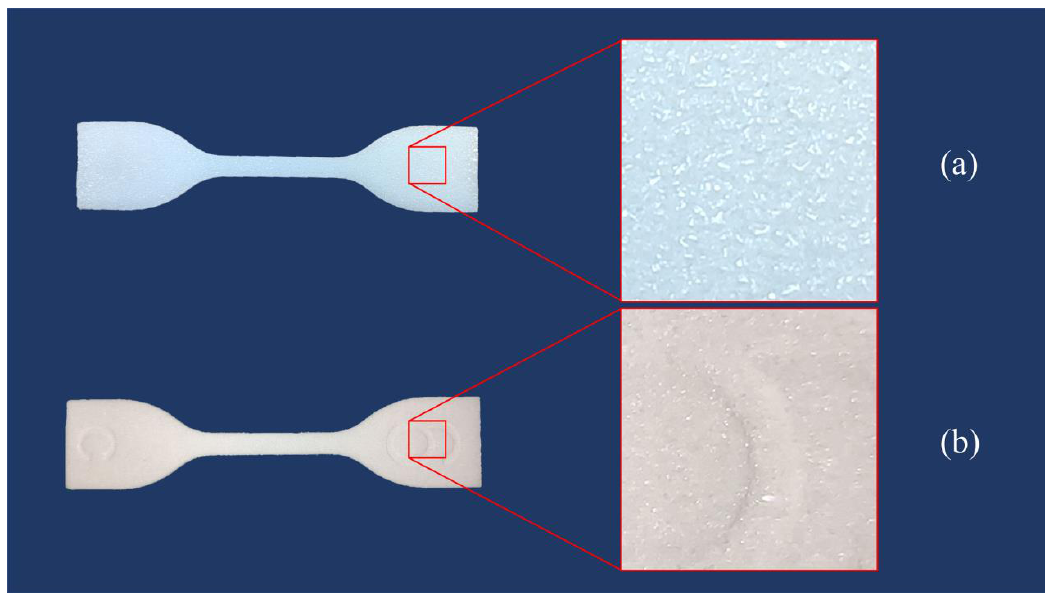
Figure 5. Comparison of specimen surfaces: ( a ) specimen with post-processing and ( b ) specimen without post-processing.